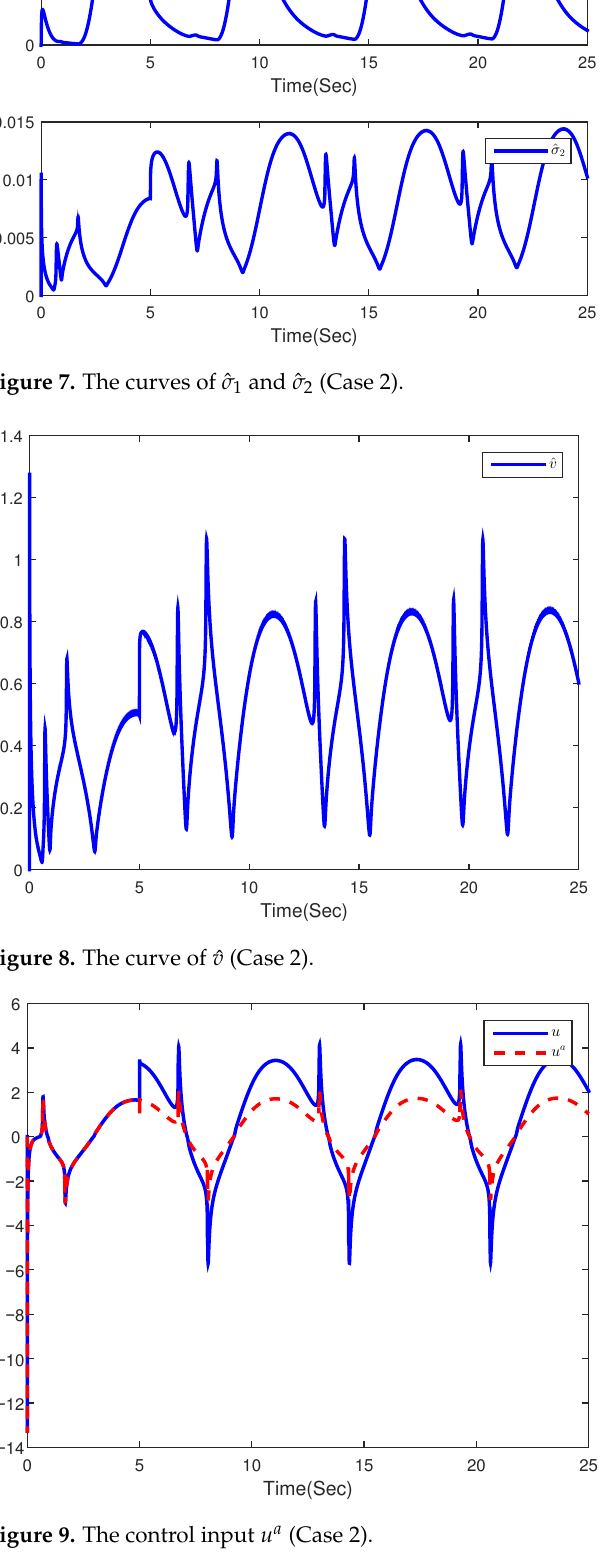
Figure 9. The control input u a (Case